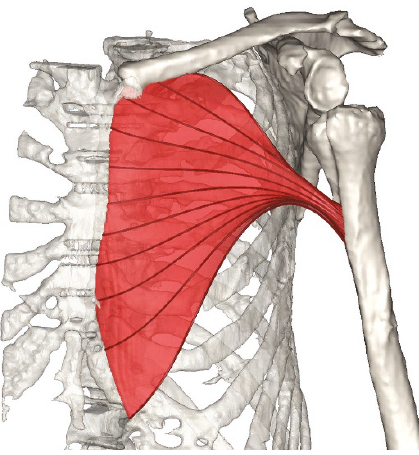
Figure 3: Illustration of the pectoralis major muscle including the muscle surface patch and a limited number of muscle